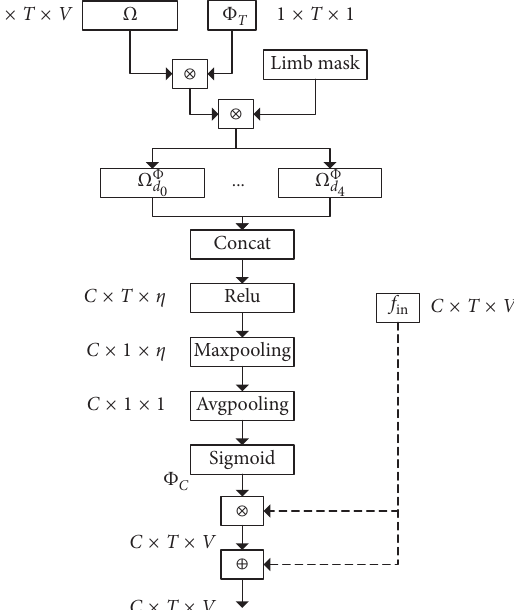
Figure 2: Local posture motion-based channel attention module